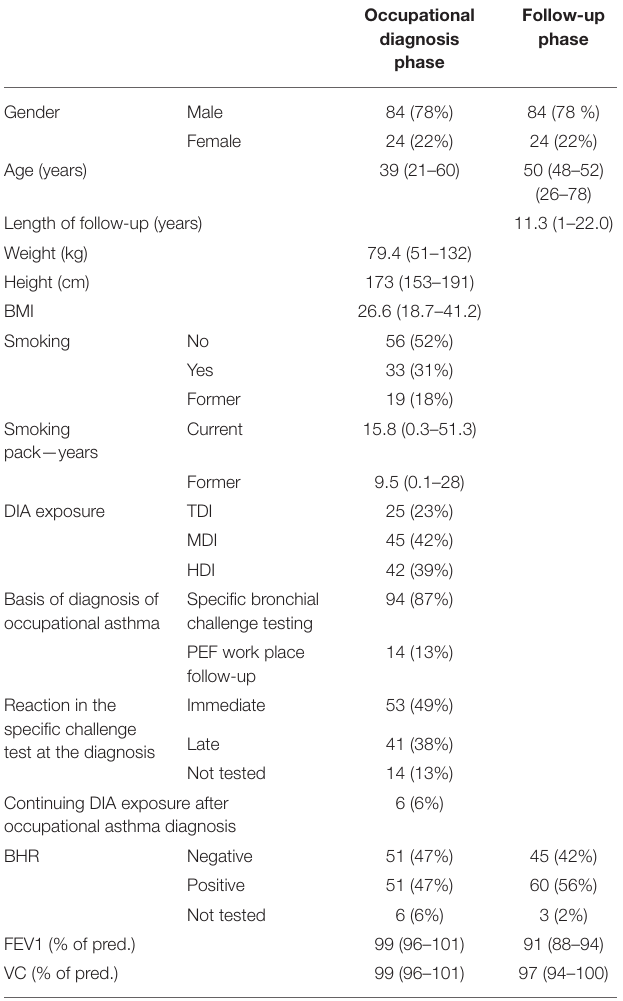
TABLE 1 | Anthropometric data, smoking, exposure, hyperreactivity, and diagnostic criteria of occupational asthma of the